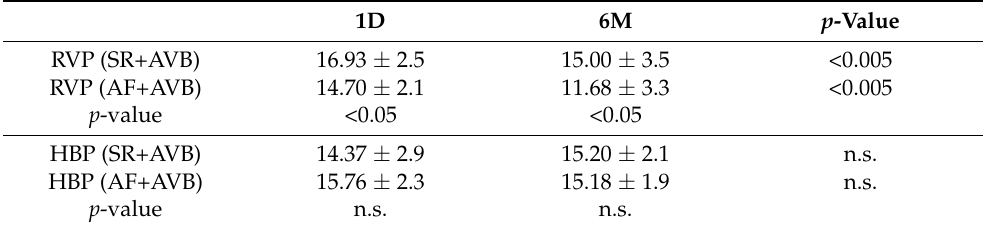
Table 3. Comparison of global longitudinal strain (GLS) between patients with sinus rhythm and atri- oventricular block (SR+AVB) vs. patients with atrial fibrillation and atrioventricular block (AF+AVB) immediately after pacemaker implantation (1D) and at 6-month follow-up visit (6M). Abbreviations: RVP—right ventricular pacing; HBV—His bundle